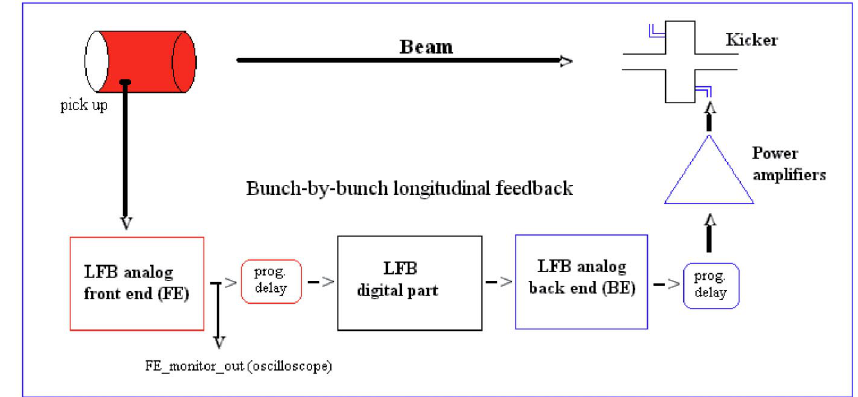
FIG. 1. (Color) Block diagram of the longitudinal feedback